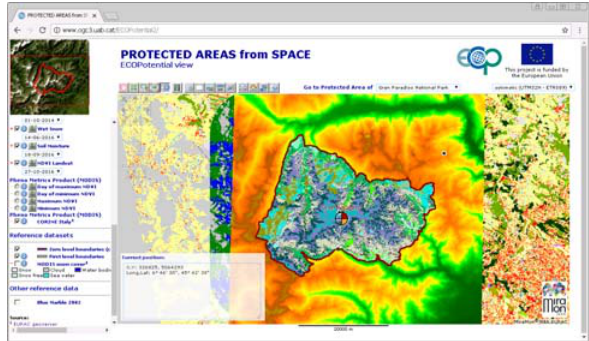
Figure 6. Screenshot for the Gran Paradiso National Park, showing, on the left, the legend with some of the layers, and in particular, the phenometrics layer.